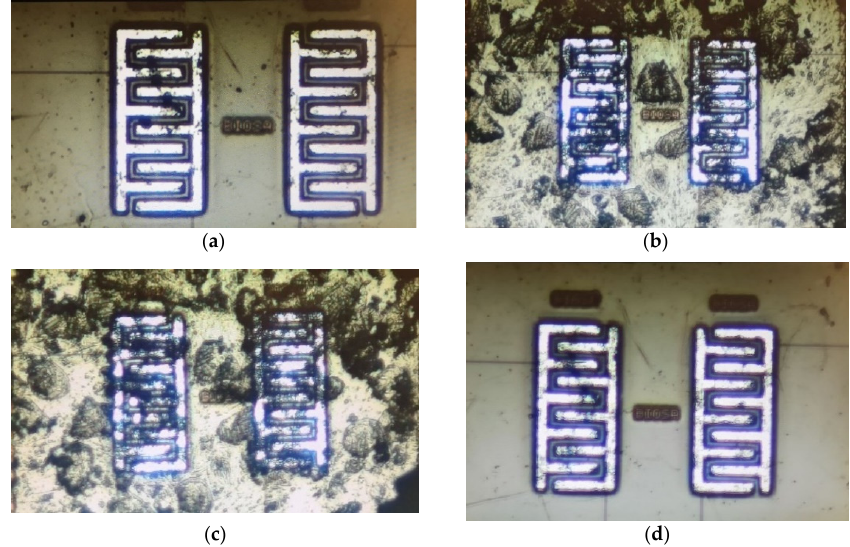
Figure 19. The microscopic images of the surface of the chip for the second experiment: ( a ) After washing and before Run 1; ( b ) After putting the first sample (Run 1); ( c ) After putting the second sample (Run 2); ( d ) The cleaned surface after Run 2.